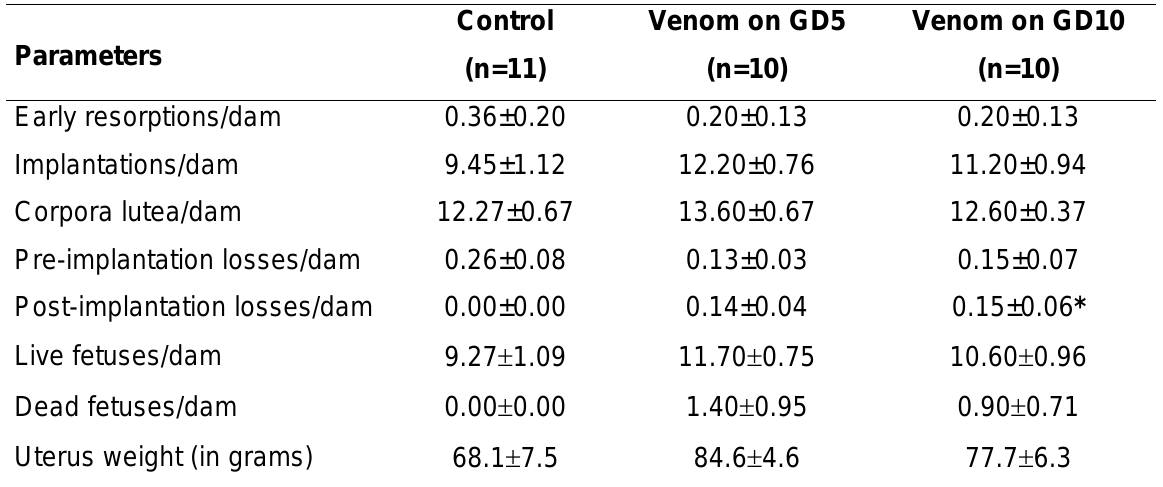
Figure 1 . Maternal weight gain, in grams, of rats treated with Tityus serrulatus venom, 3.0mg/kg, on the 5 th and on the 10 th gestation day (GD). Values represent the mean ± SEM. n = Number of dams. No significant difference among groups was observed. Table 1. Reproductive parameters of pregnant rats treated with Tityus serrulatus venom, 3.0mg/kg, on the 5 th and on the 10 th gestation day (GD)